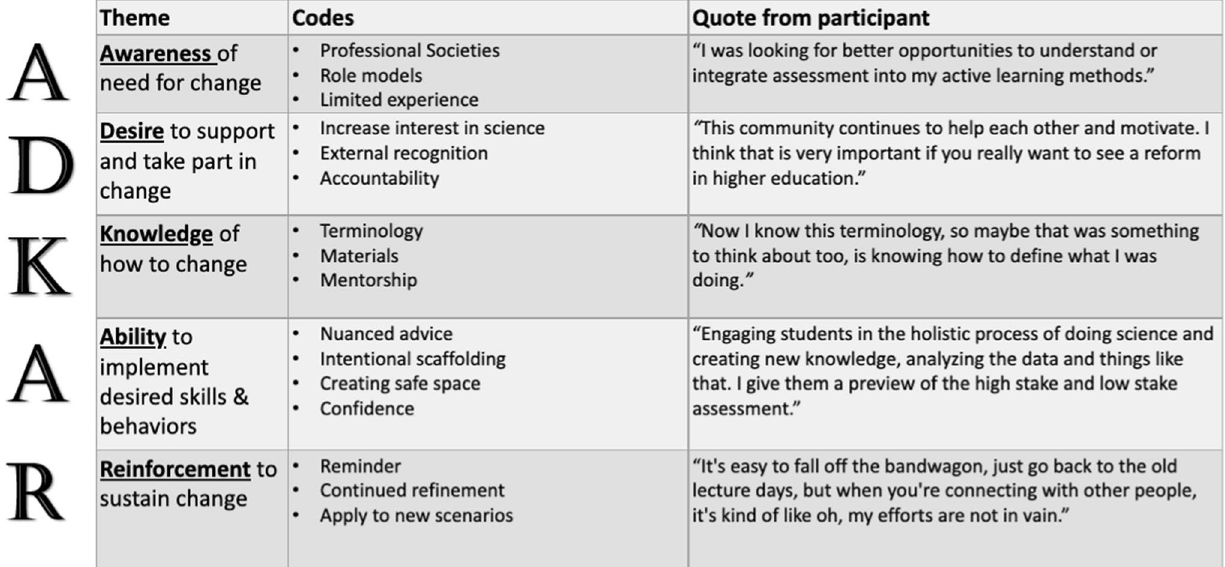
Table 1. Alignment of codes and the ADKAR change